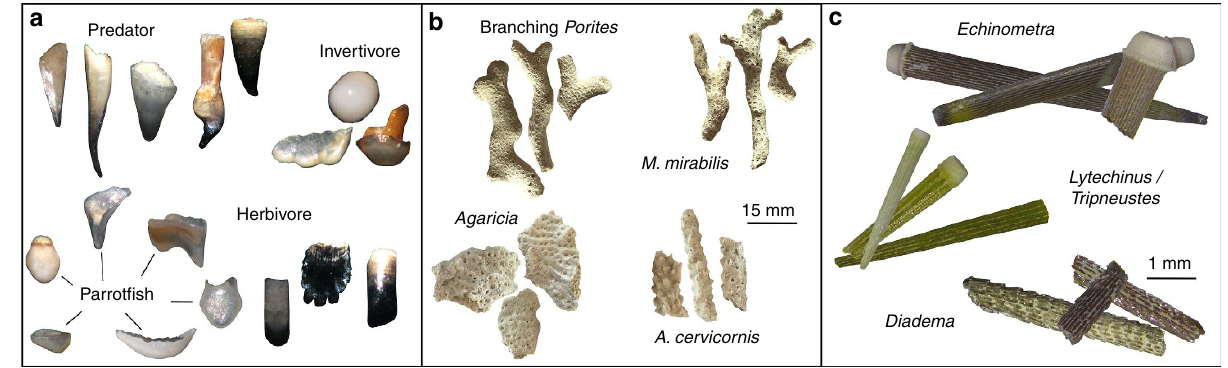
Figure 2 | Major subfossil groups preserved in reef matrix cores. ( a ) Fish teeth functional groups and variety of parrotfish tooth morphotypes. Teeth range from 500–63 m m in size but majority are 250–104 m m; images not to scale. ( b ) Common coral taxa identified from skeletal fragments. ( c ) Common urchin taxa identified from